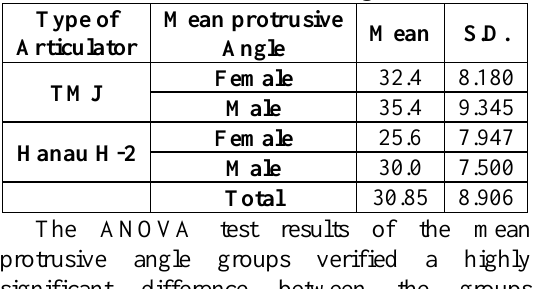
Table 1: Descriptive Statistics of the Mean Protrusive Angle Verified by TMJ & Hanau H-2 Articulators (in degrees).